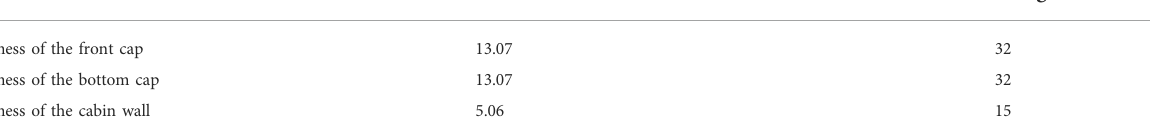
TABLE 2 Design parameters of the